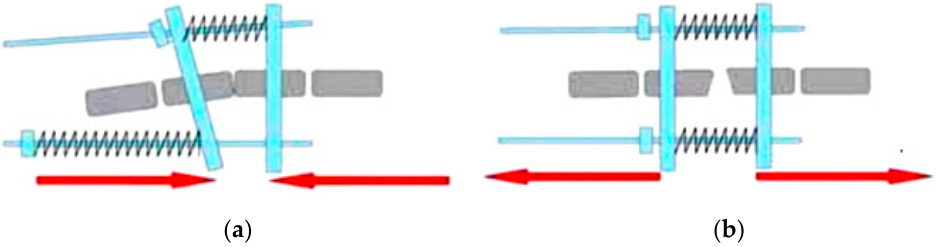
Figure 7. Scheme of forces applied during the experiment: ( a ) compression, group II; ( b ) distraction, group III.